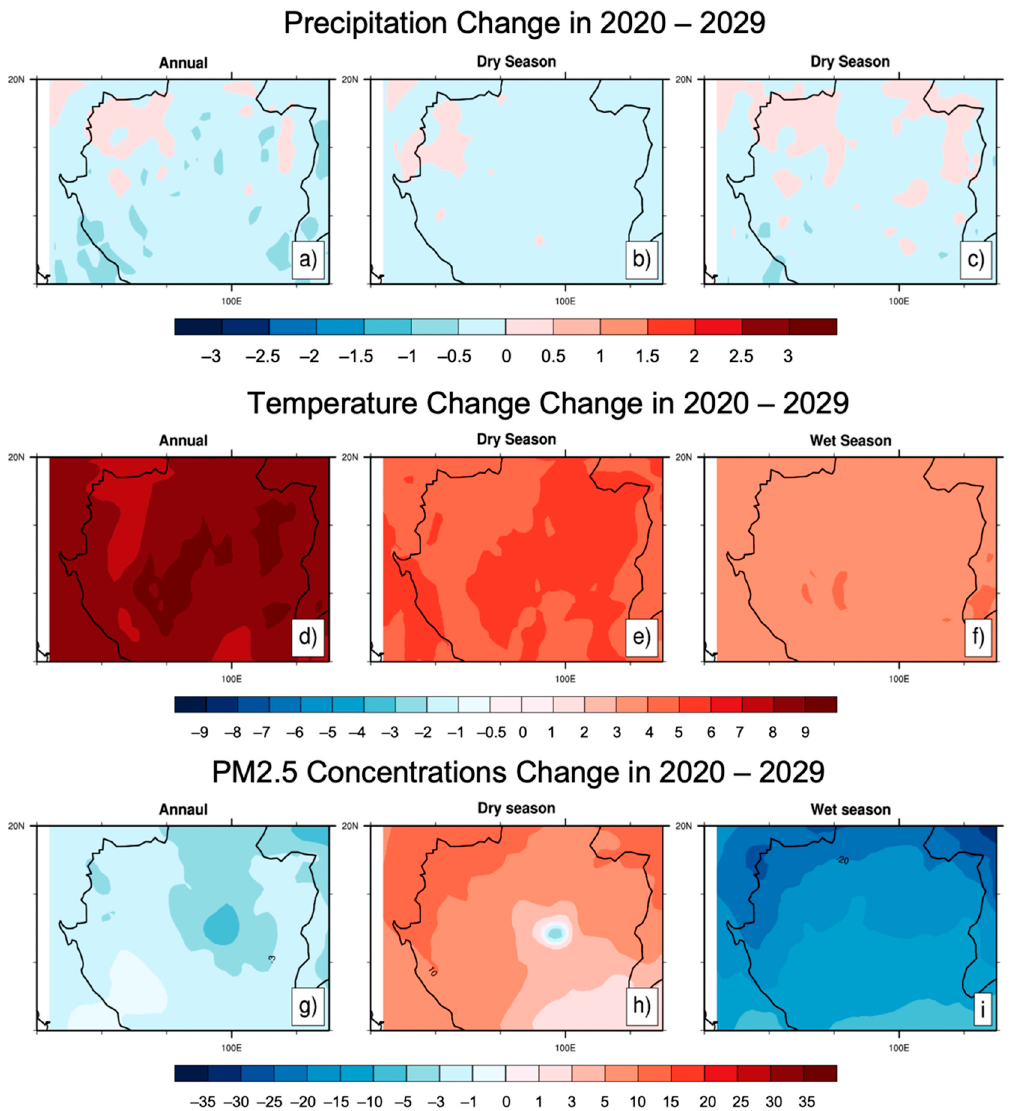
Figure 5. The difference of ( a ) annual precipitation, ( b ) dry season precipitation, and ( c ) wet season precipitation, ( d ) annual temperature, ( e ) dry season temperature, ( f ) wet season temperature, ( g ) annual PM 2.5 , ( h ) dry season PM 2.5 , and ( i ) wet season PM 2.5 concentration between year 2020–2029 and 1990–1999 over northern Thailand.